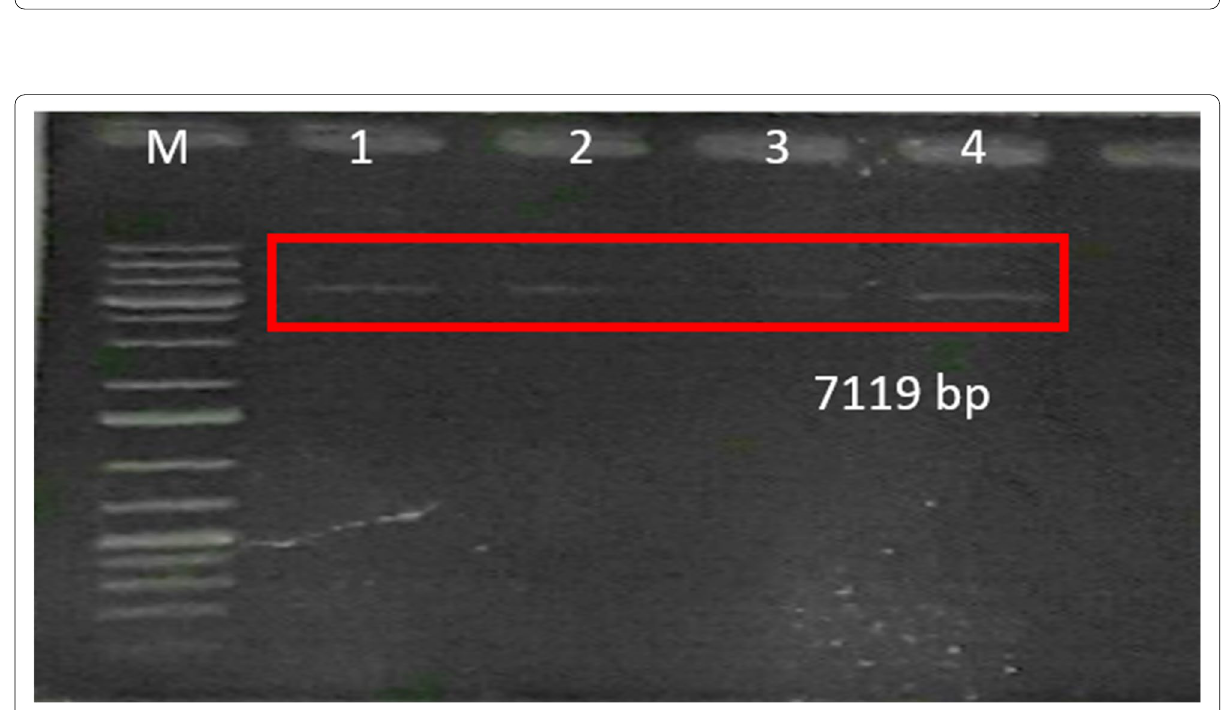
Fig. 5 Electrophoregram of plasmid pETSUMO-L1HPV52 extracted from E. coli BL21 DE3 expression vector before production. M: O’Gene Ruler 1kb plus DNA ladder (Thermo); code number 1–4 represent transformant’s colonies number. Only 1 colony out of 6 colonies was having pETSUMO-L1HPV52 plasmid in right direction. After colony multiplication, the 4 of those multiplied colonies were re-tested by digestion using XbaI and DNA band at 7113bp were seen on agarose gel as positive confirmation of integration into expression